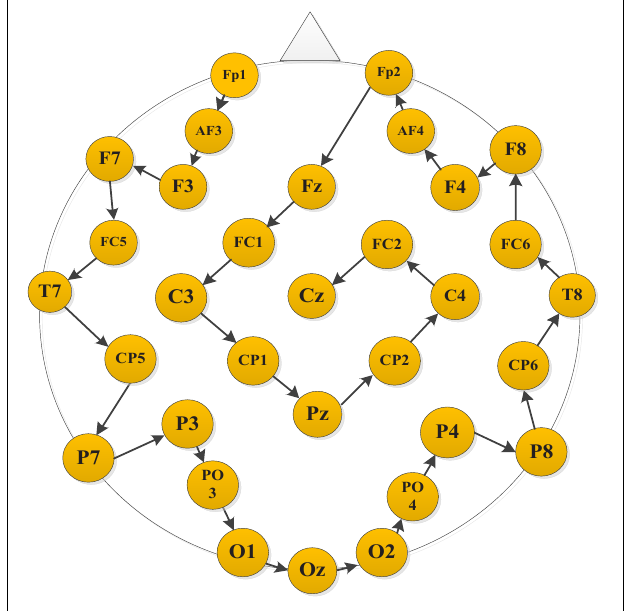
FIGURE 2 | Brain data-driven